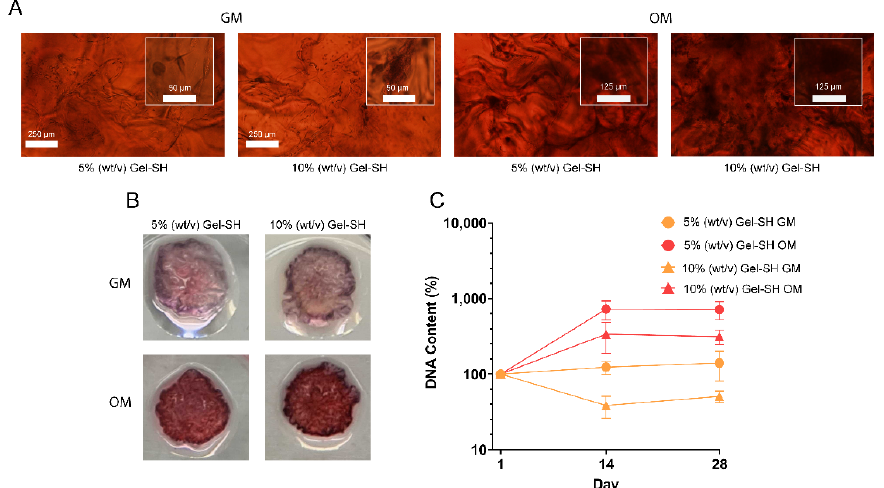
Figure 8. Osteogenic differentiation of patient-derived preosteoblasts in Gel-SH/PEG-4MAL hydro- gels. ( A ) Day 28 alizarin red staining (ARS) of patient-derived preosteoblast-laden Gel-SH/PEG- 4MAL hydrogels cultured using either α-MEM growth media (GM) or osteogenic media (OM). n = 6; ( B ) Day 28 macroscopic images of ARS-stained, patient-derived preosteoblast-laden Gel-SH/PEG- 4MAL hydrogels; ( C ) DNA content of patient-derived preosteoblasts encapsulated in Gel-SH/PEG- 4MAL hydrogels over time, normalized to hydrogel weight and day 1 DNA content ( n ≤ 5; mean ± SEM).